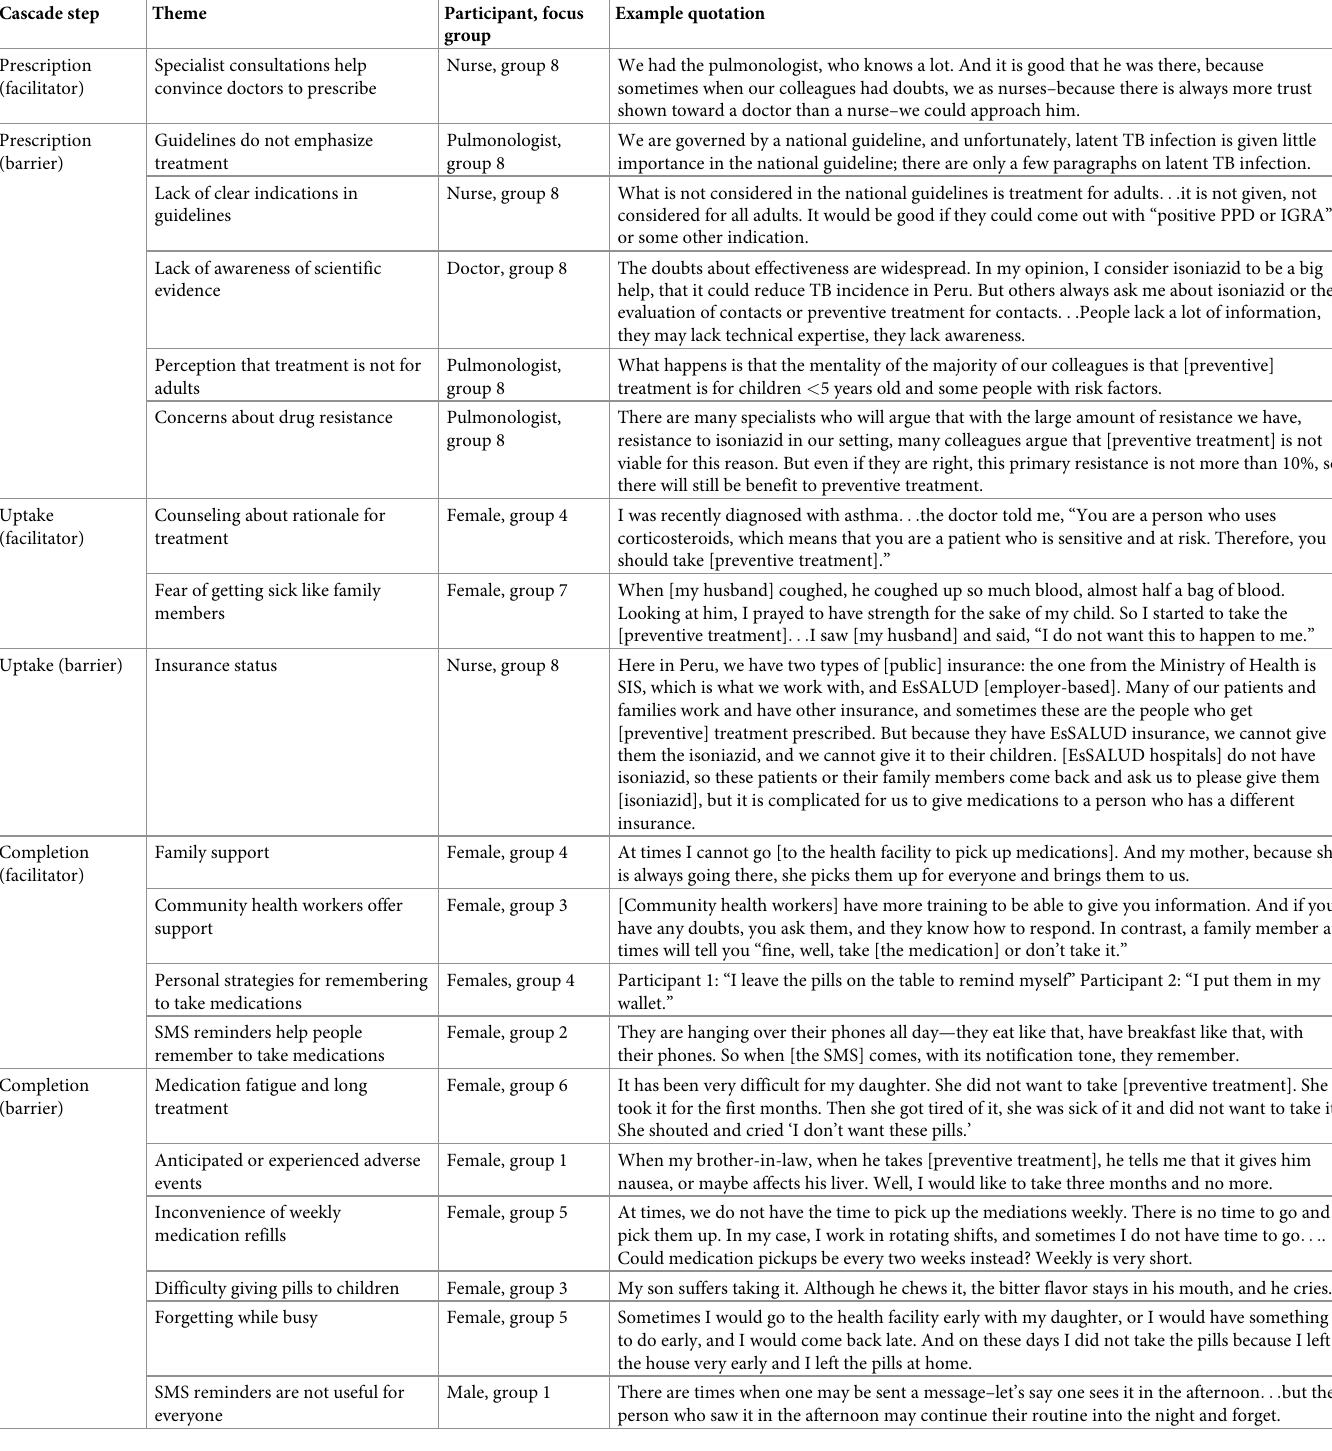
Table 3. Representative quotations illustrating facilitators and barriers to TB preventive treatment, by cascade